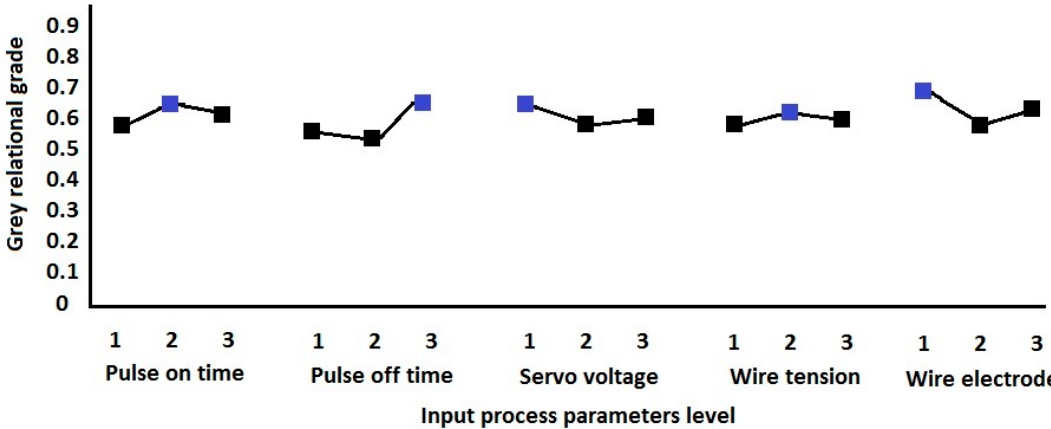
Figure 3. Based optimal process parameters computation.